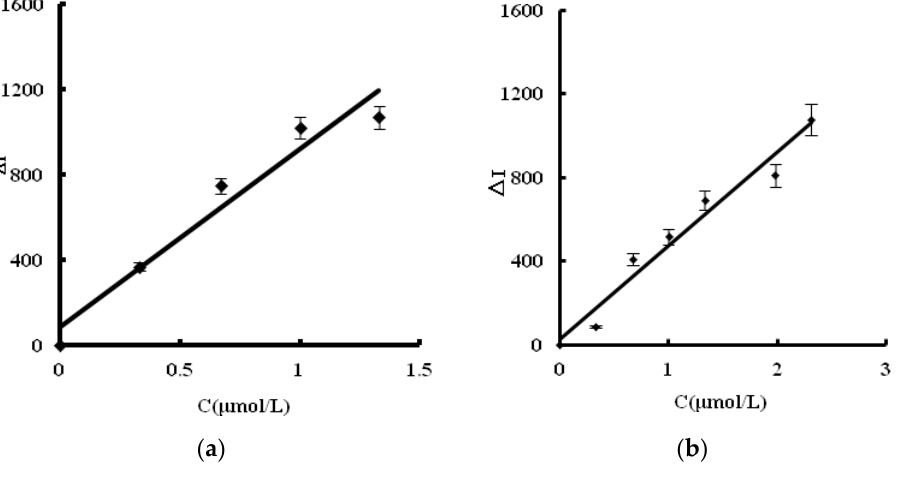
Figure 5. SERS working curve. ( a ) C 60 ; ( b ) C 60 OH . Table 1. Comparison of analytical methods for determination of SO 42+ .